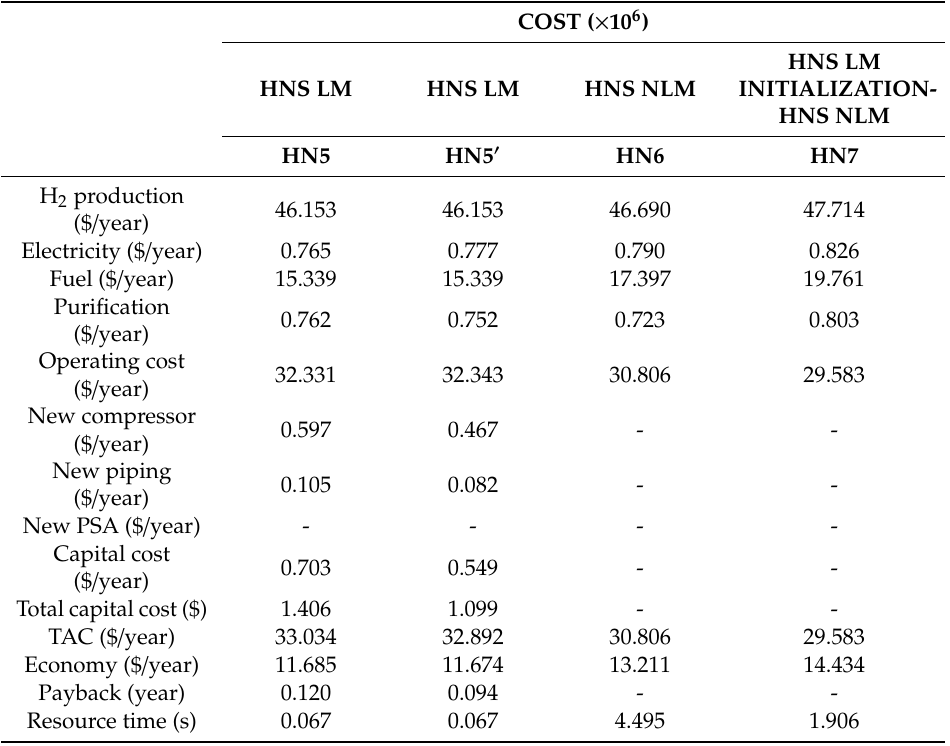
Table 6. Results obtained in the di ff erent optimizations models for example